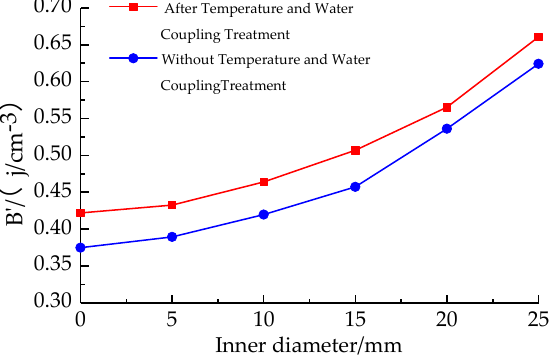
Figure 17. Energy dissipation per unit volume diagram.